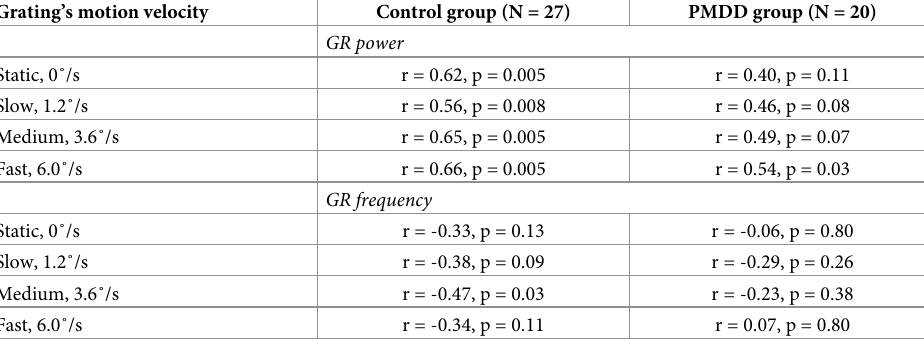
N—number of subjects; p-values are FDR-corrected for multiple comparisons.